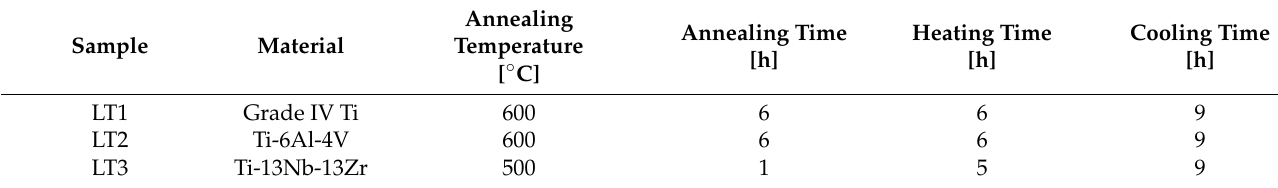
Table 5. Stress relief parameters.